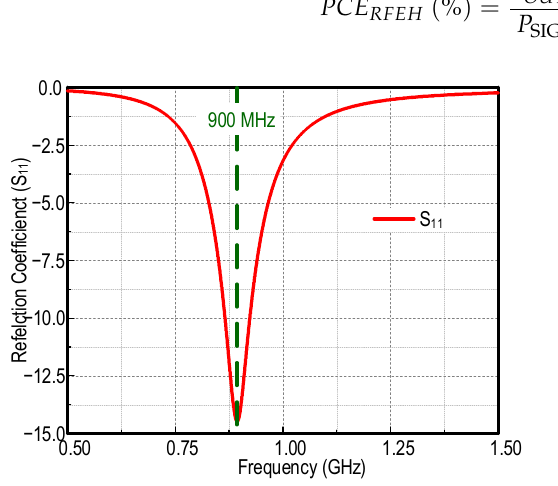
Figure 15. Postlayout simulation of S 11 . The PCE of the rectifier is calculated by incorporating the power reflection, denoted by (12), while the front-end RFEH is calculated by (13). The power reflection is not in- cluded in (13) as a matching network is adopted; hence, it achieves maximum power transfer at the desired frequency. Figure 15 illustrates the post-layout result on the reflec- tion coefficient, S 11, of the proposed front-end RFEH. It is matched at 900 MHz with an S 11 of − 14 dB. P OUT refers to the output power of the rectifier, with V OUT2 /R L , P SIG is the input signal excluding the power reflection, and |S 11 |is the power reflection. The rectifier achieves a peak PCE of 88.7% at − 22 dBm, while the fully integrated RFEH front-end ob- tains a peak PCE of 36%.